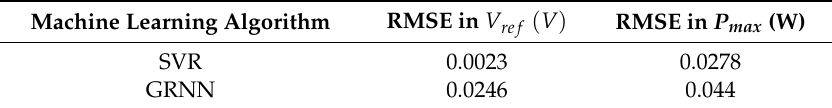
Figure 11. Predicted and measured P max for di ff erent irradiation levels using: ( a ) SVR; ( b ) GRNN. Table 2. RMSE in both machine learning